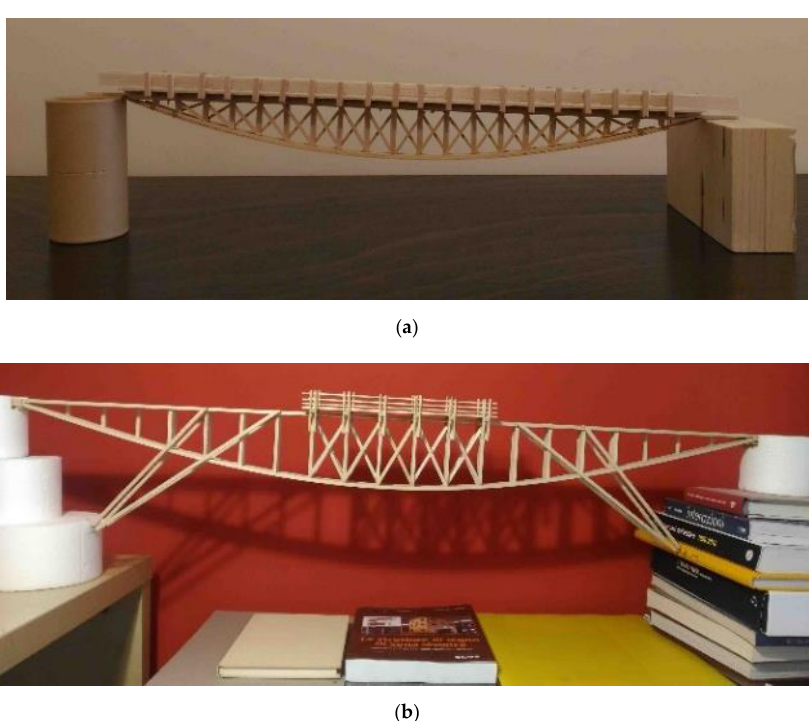
Figure 4. First longitudinal profiles for the timber bridge: ( a ) arch lower-chord truss scheme; ( b ) arch lower-chord strut system with V-struts.